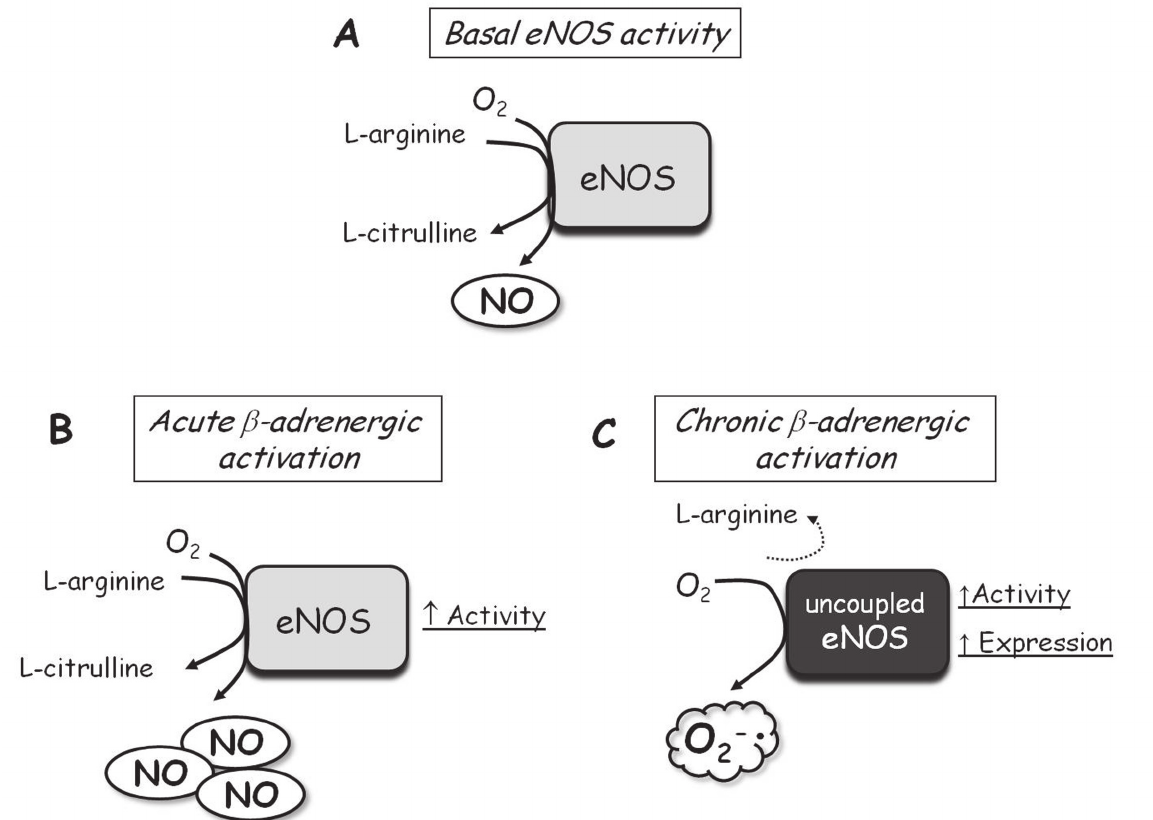
Figure 4. Schematic presentation of the effect of acute and chronic β-adrenergic activation on endothelial nitric oxide synthase (eNOS) activity, expression and uncoupling. A , In normal vessels, basal eNOS activity oxidizes L-arginine, producing L-citrulline and nitric oxide (NO) at physiological rates, contributing to vascular tone maintenance. B , Acute β-adrenergic activation induced by β-adrenoceptor agonists induces eNOS activity and could increased endothelial NO release. C , Sustained elevated catecholamine levels could induce overactivation of β-adrenoceptors that enhance activity and protein expression of eNOS but, in turn, eNOS becomes uncoupled, gen - erating superoxide anion (O 2-·